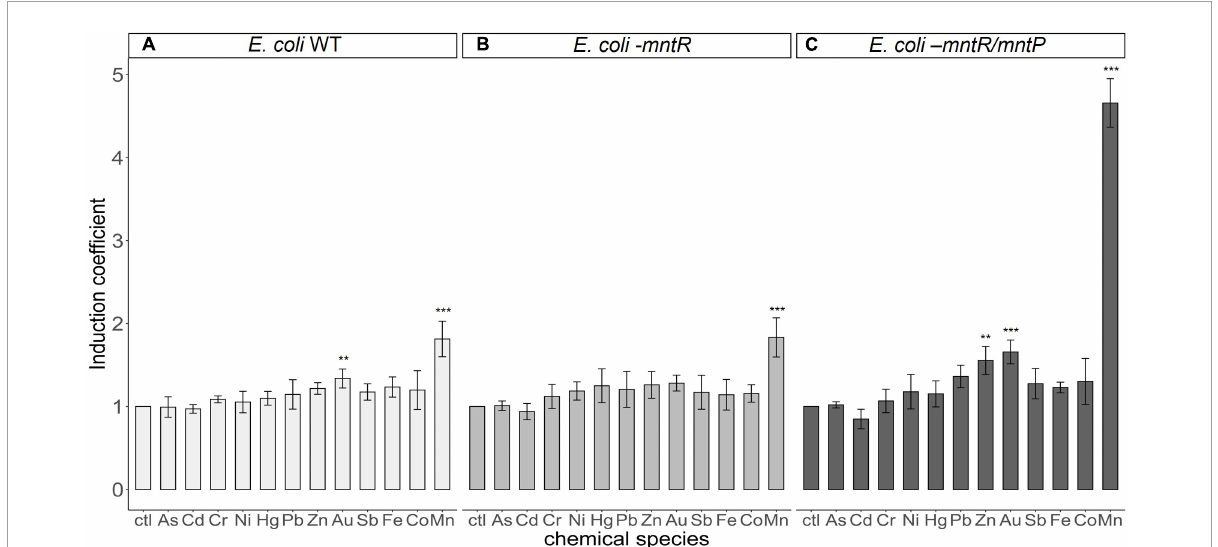
FIGURE6 Metal(loid) selectivity of biosensors harboring pMntS-eGFP and pCDF-MntR based on host strains. The fluorescence signals of biosensors based on (A) E. coli BL21 WT, (B) Escherichia coli-mntR , and (C) E. coli-mntP/mntR as host strains were measured after 2 h of exposure to 5 µ M of different heavy metal(loid)s. The data was obtained from more than three times of replicated experiments. The differences in the fluorescence signals among the heavy metal(loid)s were compared using analysis of variance with post hoc Tukey’s test (** p < 0.01 and *** p <